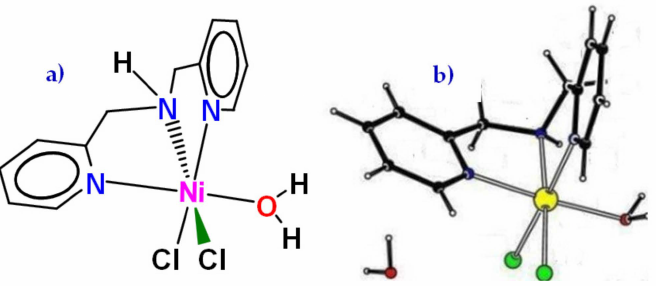
Figure 2. ( a ) The structure of [(BPA)NiCl 2 (H 2 O)] · H 2 O ( NiBPA · H 2 O), as well as ( b ) the overall connectivity and geometry of as obtained from a preliminary X-ray structure